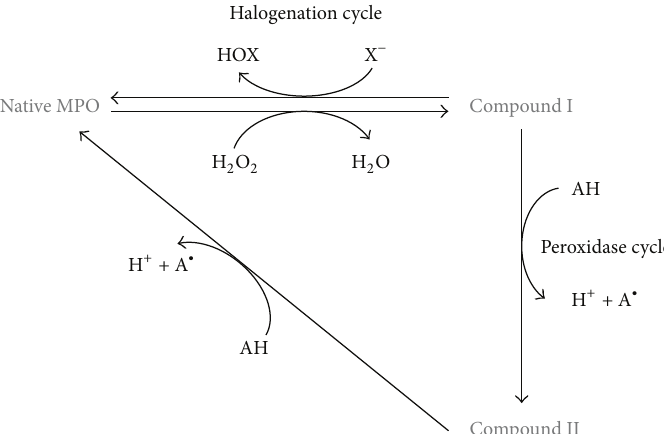
Figure 1: Scheme of the interconversion between different oxidized states of myeloperoxidase. The first reaction is the oxidation of native MPO to Compound I by a two-electron reaction. In the halogenation cycle, Compound I is backconverted to native MPO, and a two-electron oxidation of (pseudo-) halide generates hypo- (pseudo-) halogenous acid. In the peroxidase cycle, Compound I can oxidize an electron donor via 1-electron process transforming Compound I to Compound II and the electron donor to a radical product. Compound II can be reduced to native MPO by using 1 electron from other electron